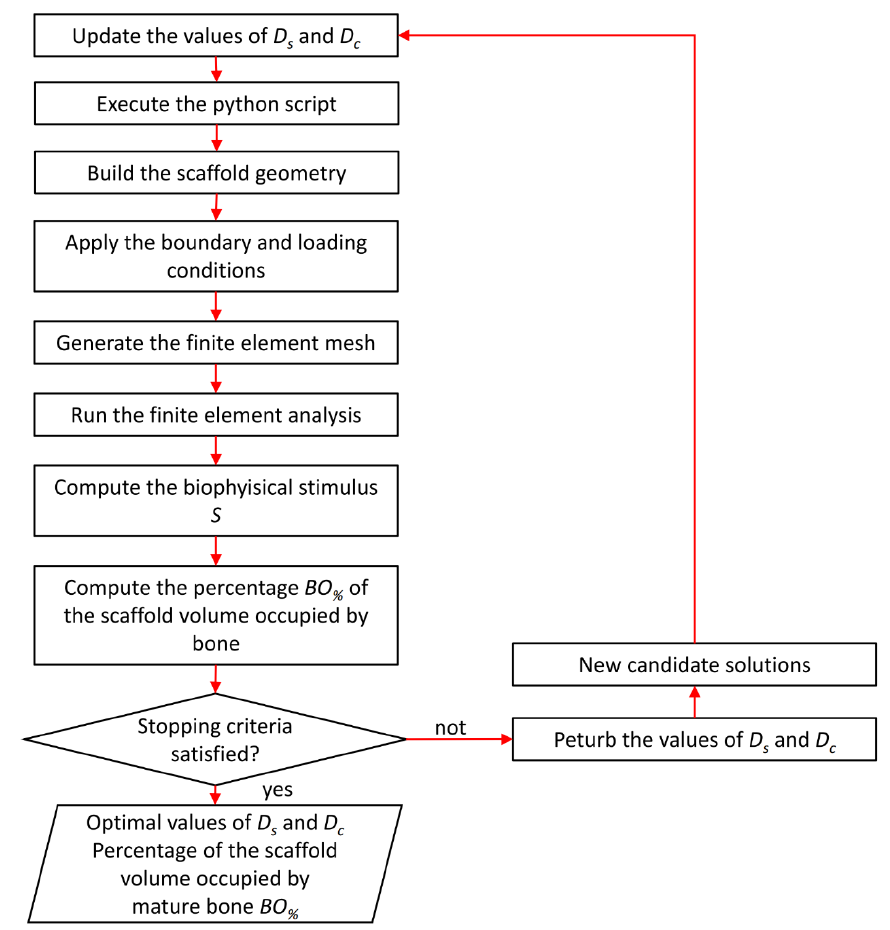
Figure 6. Schematic of the optimization algorithm implemented to determine the optimal sca ff old